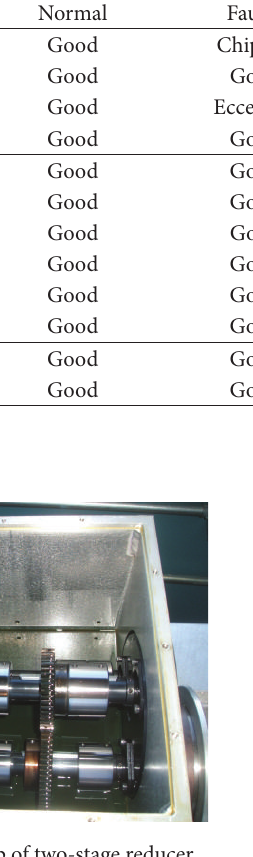
Figure 7: Physical map of two-stage